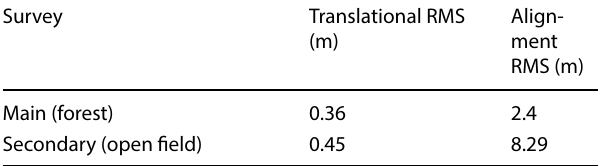
Table 1 Accuracy metrics for the forest dataset and a secondary survey Survey